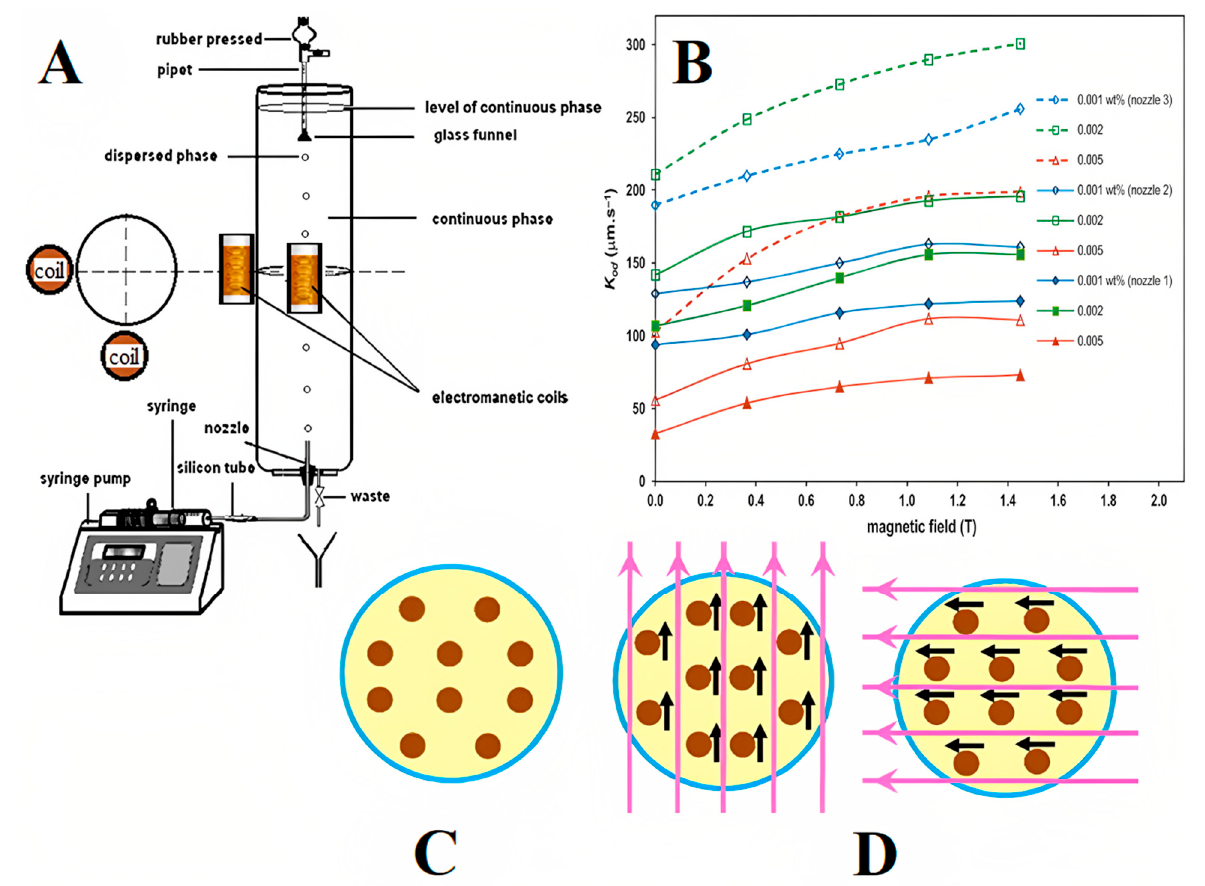
Figure 2. ( A ) Details of experimental setup; ( B ) variation of overall mass transfer coefficient with magnetic field intensity for different nozzles and NP concentrations; NPs in drops ( C ) without magnetic field and ( D ) with applied magnetic field. Reprinted with permission from Ref. [43]. Copyright 2015, Elsevier.